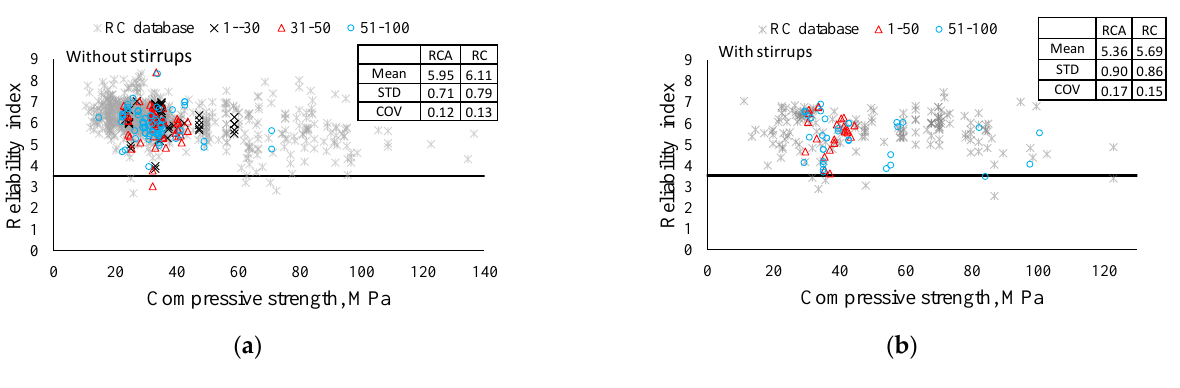
Figure 10. Reliability indices of RCA beams with RC database. ( a ) Specimens without shear reinforcement. ( b ) Specimens with shear reinforcement.